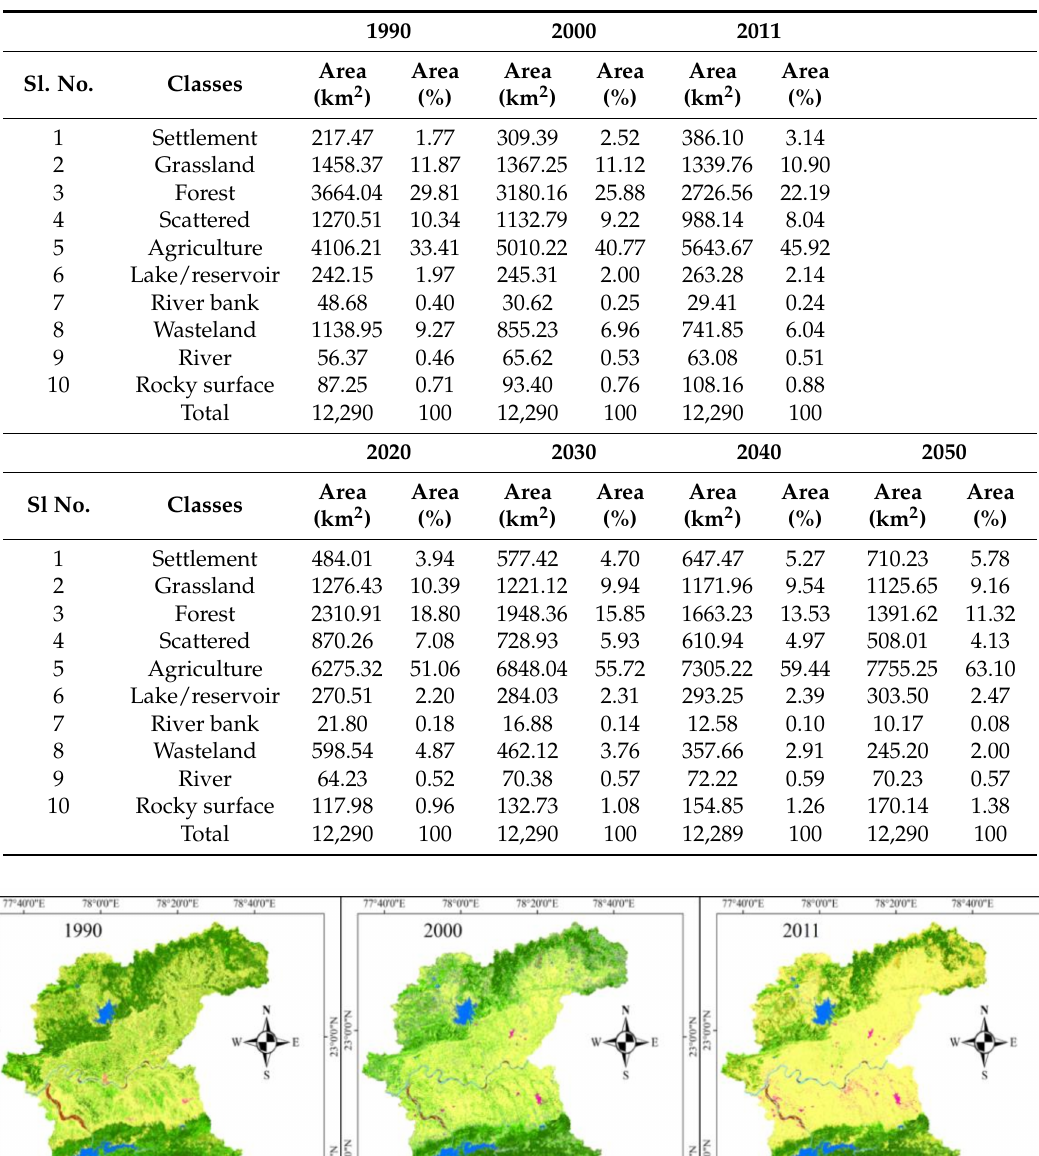
Table 3. Area of the land use classes of 1990, 2000, and 2011; Area of the land use classes of future by Markov Chain model.